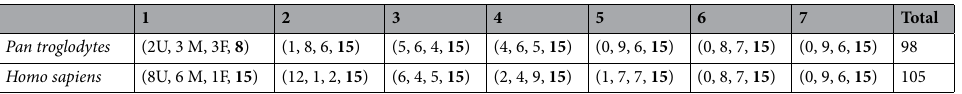
Table 1. Extant comparative sample by age and sex (U = unknown, M = male, F = female, Total). Comparative human data was derived from Native American collections housed at the American Museum of Natural History (AMNH; New York, NY) and the National Museum of Natural History (NMNH; Washington, DC) and industrialized populations from the Cleveland Museum of Natural History (CMNH; OH) and NMNH. Chimpanzee data was collected from the Museum of Comparative Zoology (Cambridge, MA), the Powell- Cotton Museum (Birchington, UK), AMNH, CMNH, and NMNH. Further information about age stage criteria may be found in the main text, Shea (1986) and Green